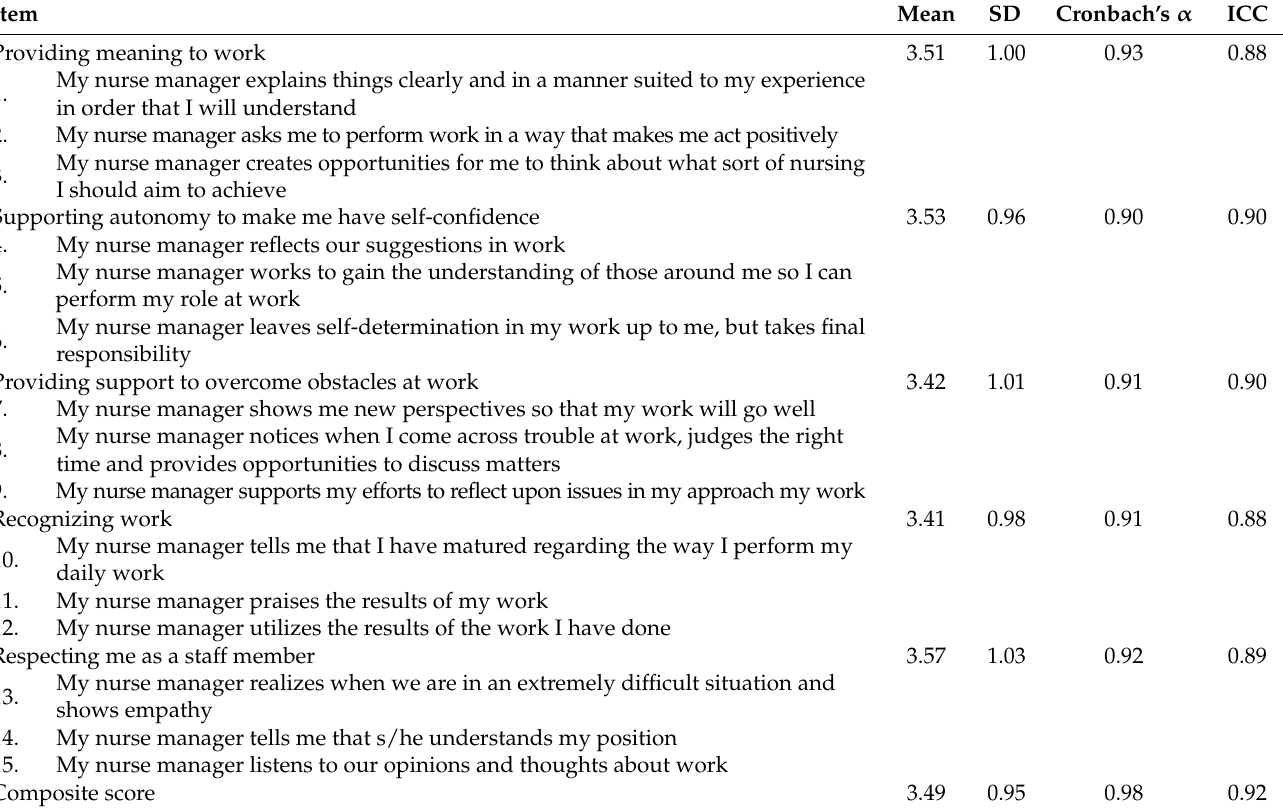
Table 1. Items, descriptive statistics, Cronbach’s α ( n = 1268), and ICC of the NMEB-SN short version ( n =